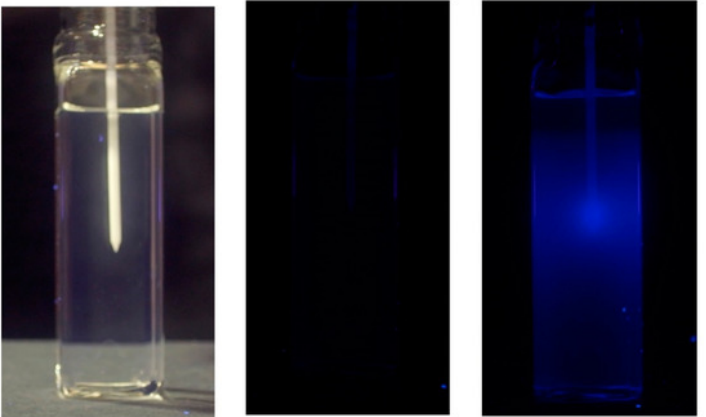
Figure 10. 3D dosimetry of a high dose-rate seed of iridium-192 with a radio-fluorescence gel of maleimido-pyrene in tertiary-butyl acrylate. Left: Photograph under visible-light prior to seed inser- tion in the catheter. Middle: Photograph under UV light prior to seed insertion. Right: Photograph under UV light 3 minutes after seed insertion. Reproduced from